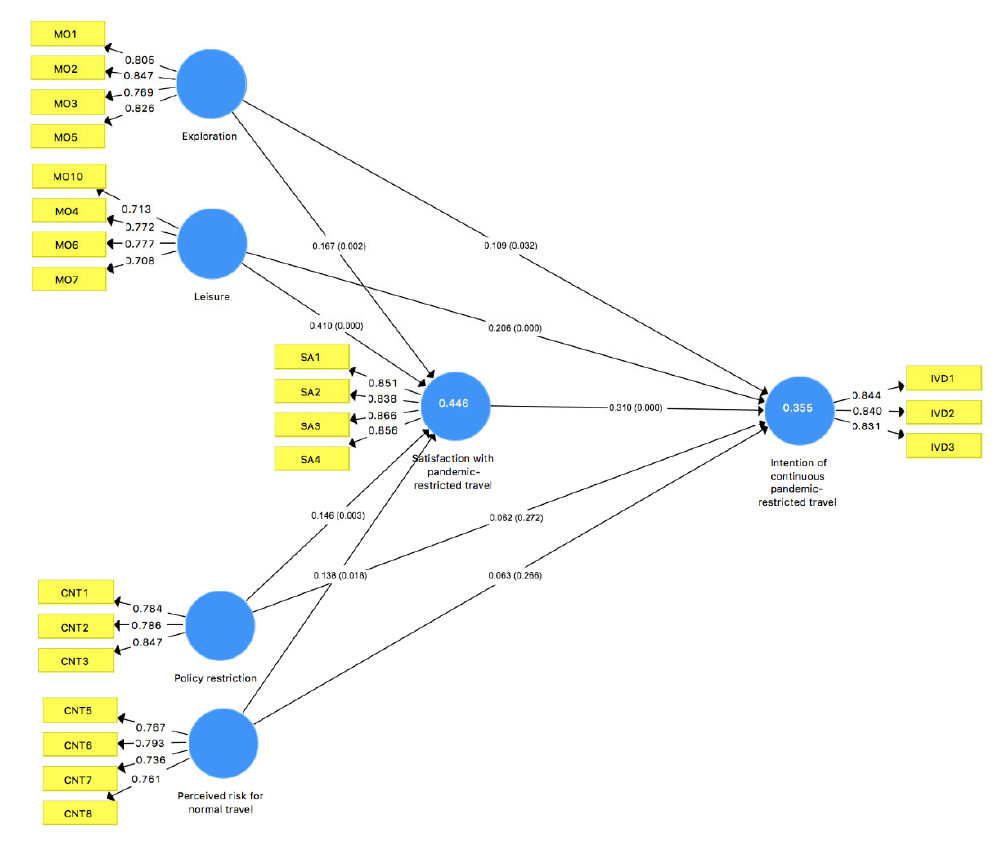
Figure 2. Results of PLS ‐ SEM analysis.